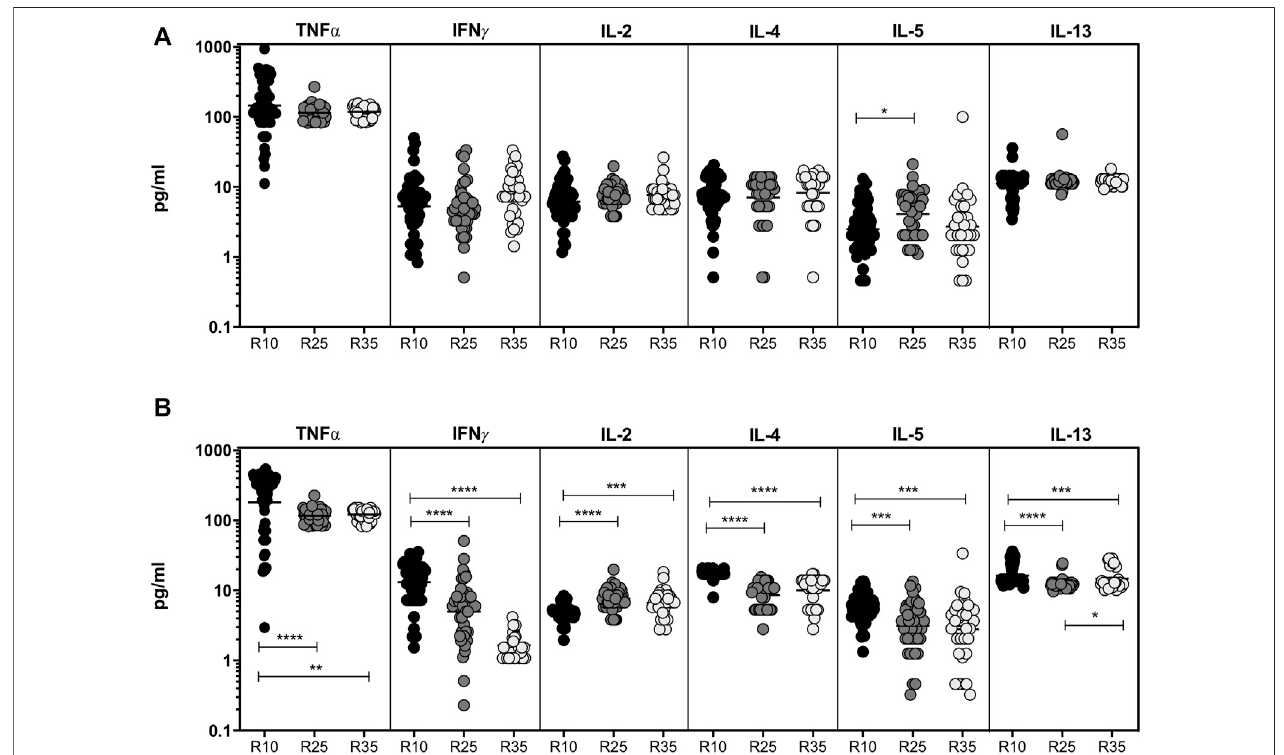
FIGURE 1 | High dose rifampicin is associated with decreased plasma levels of Type 1 and Type 2 cytokines at the second month in PTB individuals. (A) Baseline analysis of Type 1 (IFN γ , TNF α , and IL-2) and Type 2 (IL-4, IL-5, and IL-13) cytokines between the three different rifampicin (R10 [n = 57], R25 [ n = 42], R35 [n = 33]) treatedarmofPTBindividuals. (B) SecondmonthanalysisofType1(IFN γ ,TNF α ,IL-2),andType2(IL-4,IL-5,andIL-13)cytokinesbetweenthethreedifferentrifampicin (R10[ n =57],R25[ n =42],R35[ n =33])treatedarmofPTBindividuals.WeusedKruskal – WallistestwithDunn ’ smultiplecomparisonstomeasurethe p valuesand each individual were denoted using scatter